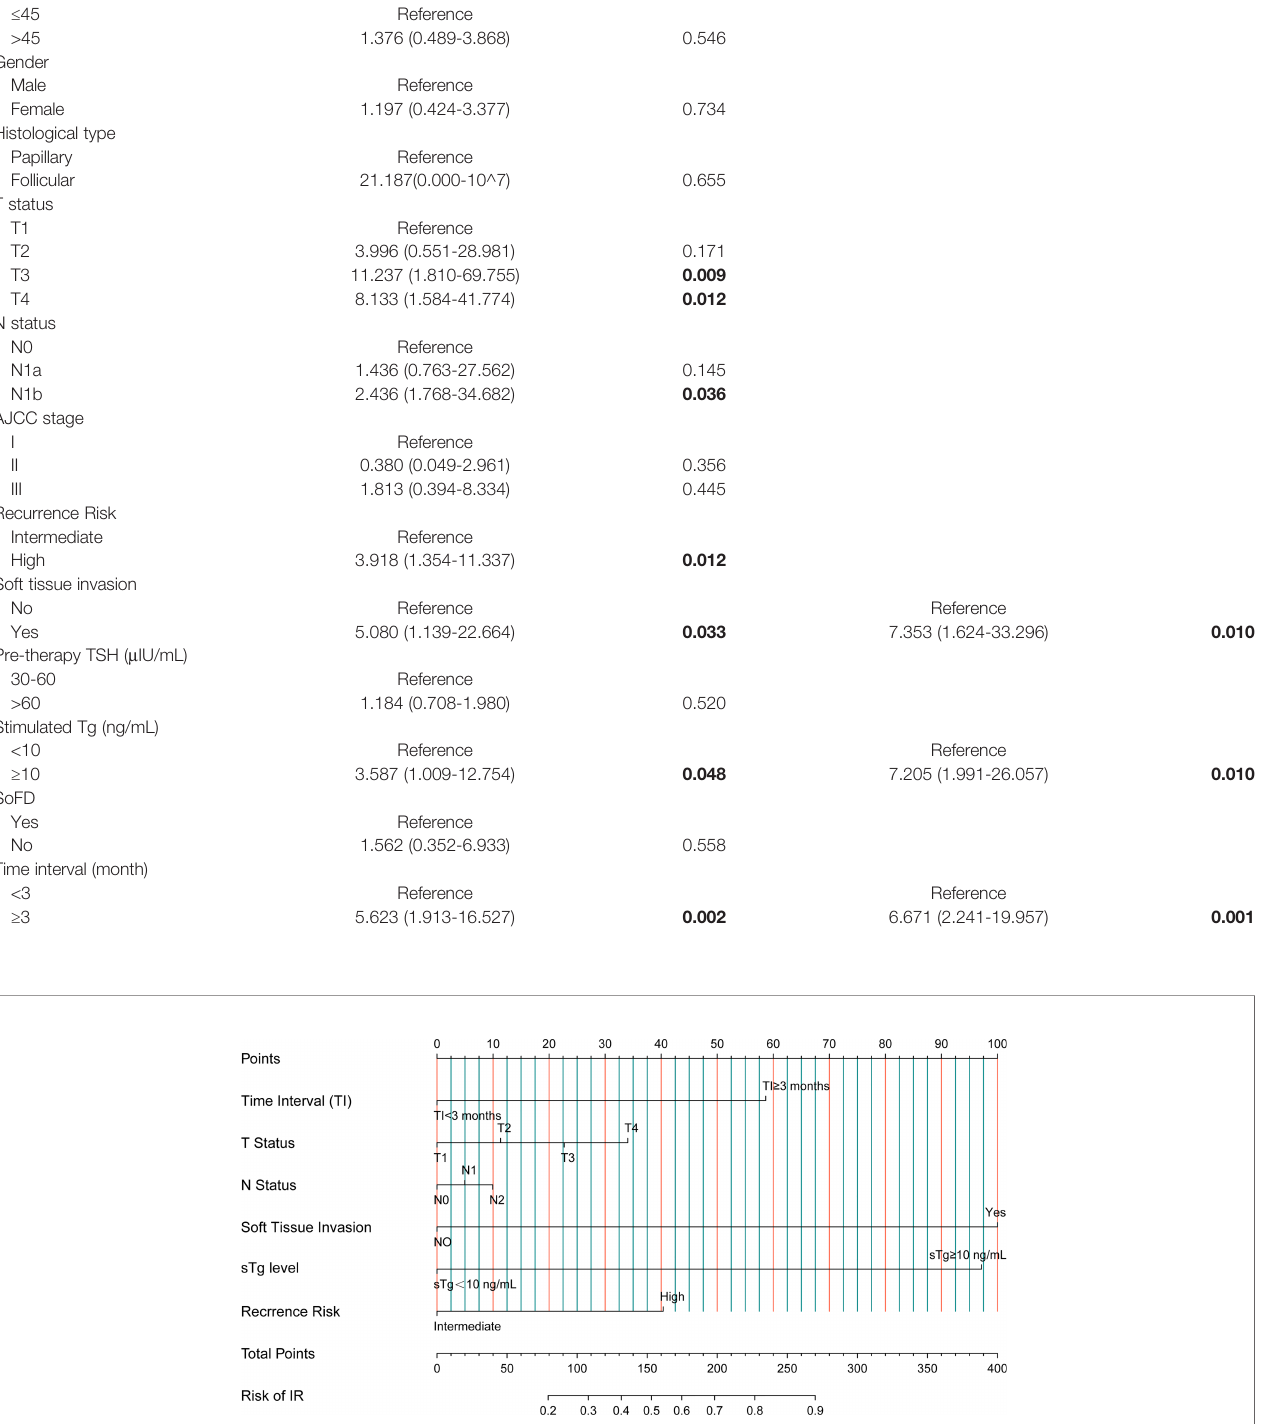
FIGURE 3 | Nomogram predicting IR rates for intermediate ‐ to high ‐ risk DTC patients receiving